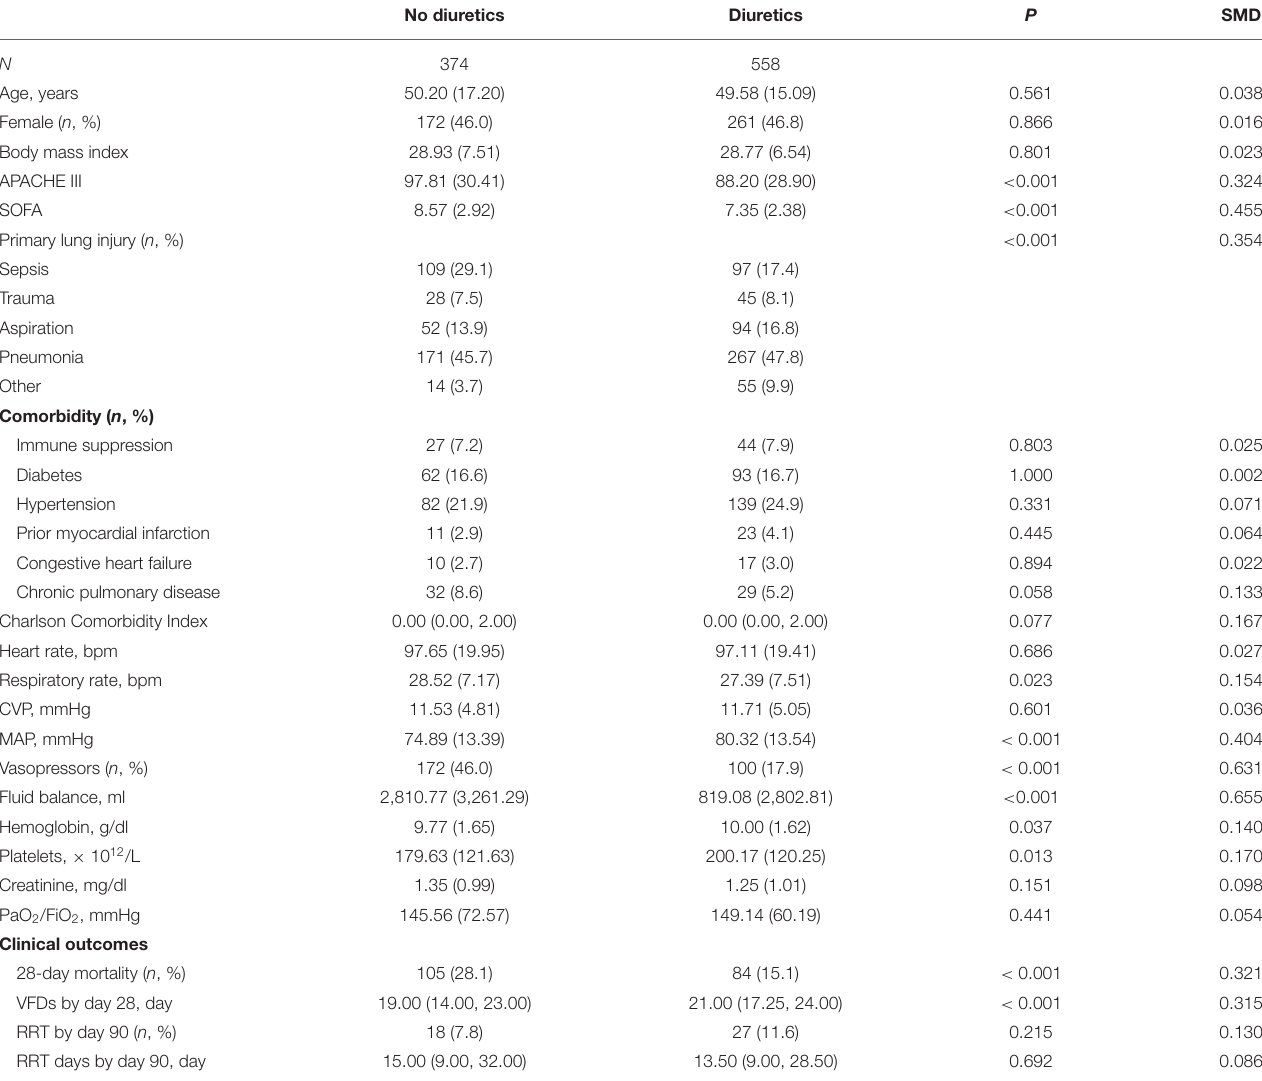
TABLE 1 | Demographic and clinical characteristics of patients in two